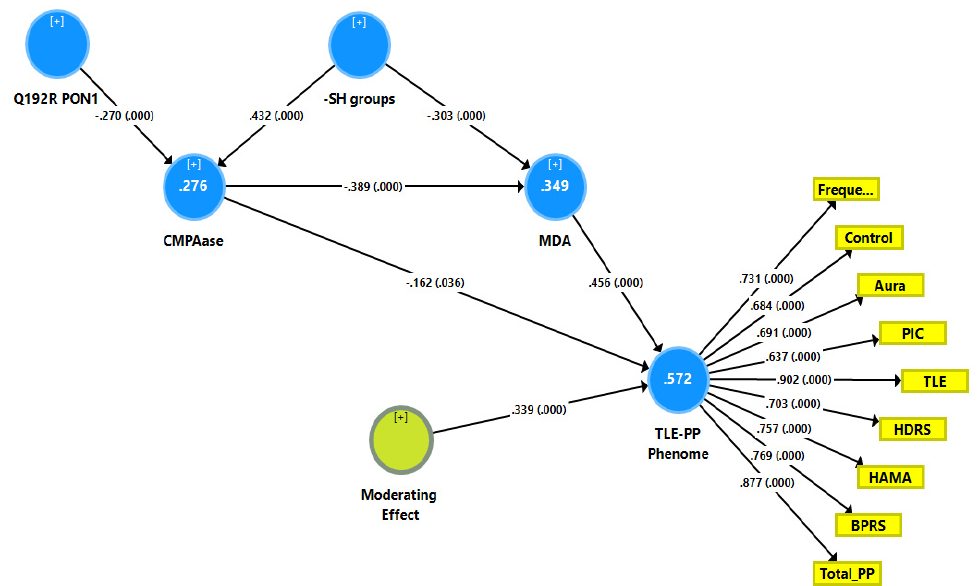
Figure 1. Results of partial least squares (PLS) showing a first causal model with the combined temporal lobe epilepsy (TLE) and psychopathology (PP) score as output variable (TLE-PP phenome) and the Q192R variant (additive model), CMPAase 4-(chloromethyl)phenyl acetate ase; -SH groups and malondialdehyde (MDA) as input variables, whereby CMPAase and MDA mediate the effects of the genetic variant on the TLE-PP phenome. Freque: frequency of seizures; control: uncontrollability of seizures; aura: history of aura; PIC: post-ictal confusion; HDRS and HAM-A: Hamilton Depression and Anxiety Rating Scales; BPRS: Brief Psychiatric Rating Scale; PP: psychopathology.